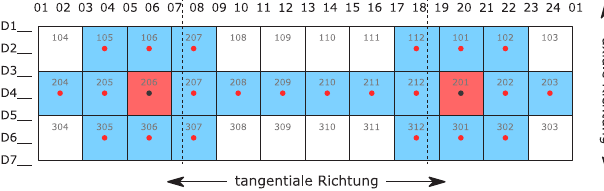
Fig. 4. Sketch of configuration 2). Detectors are positioned in the segment centers within the measurement plane and above and below the segments adjacent to the segment in front of the HPGe-detectors.